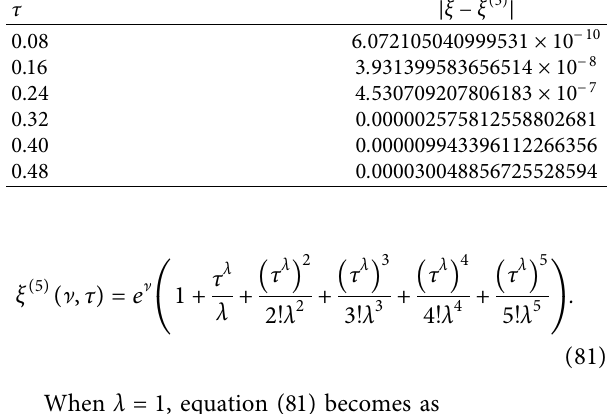
1 with ] 0 . (cid:29) (cid:29)